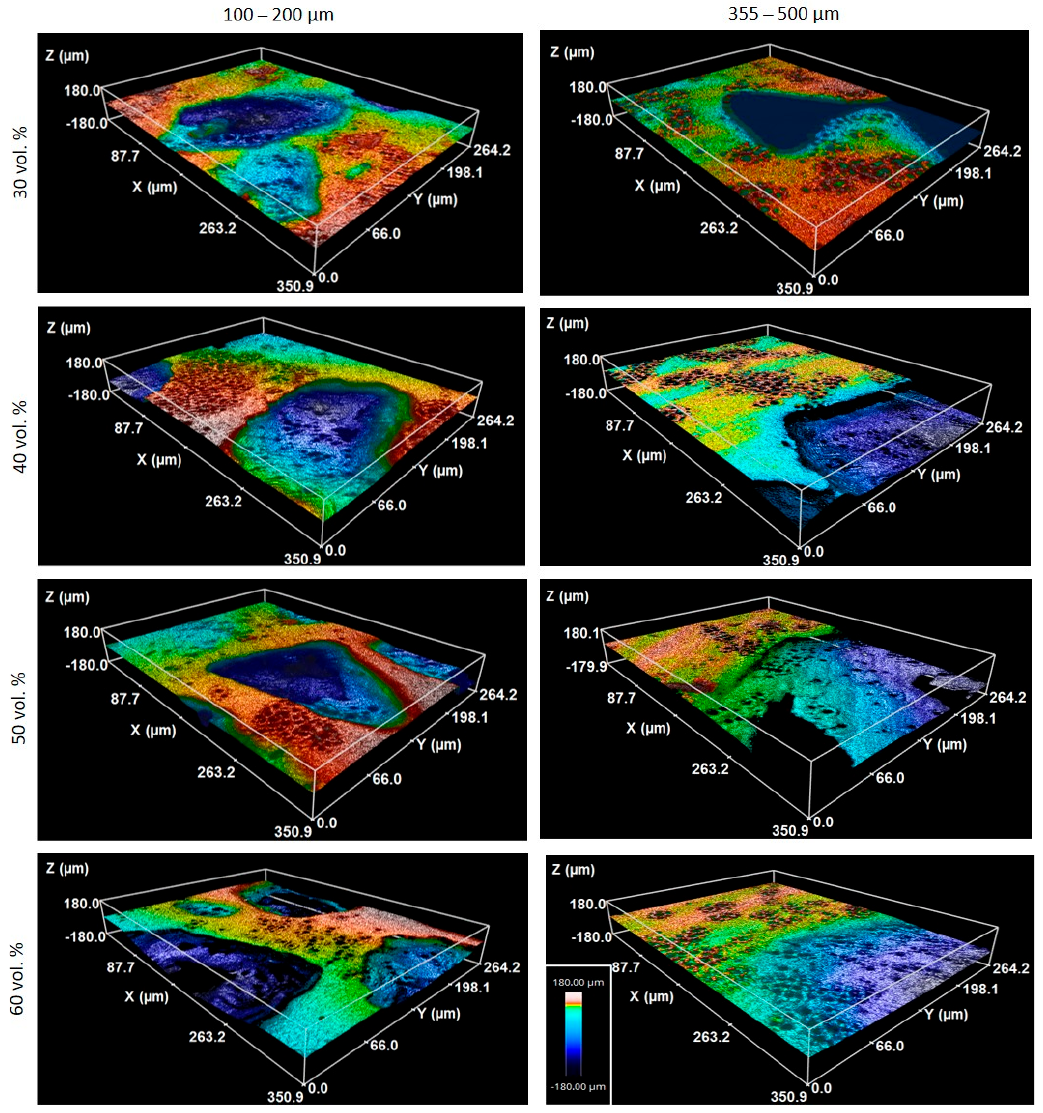
Figure 4. CLM images after the femtosecond laser treatment of the different porous c.p. Ti substrates. Common scale bar for all subfigures.